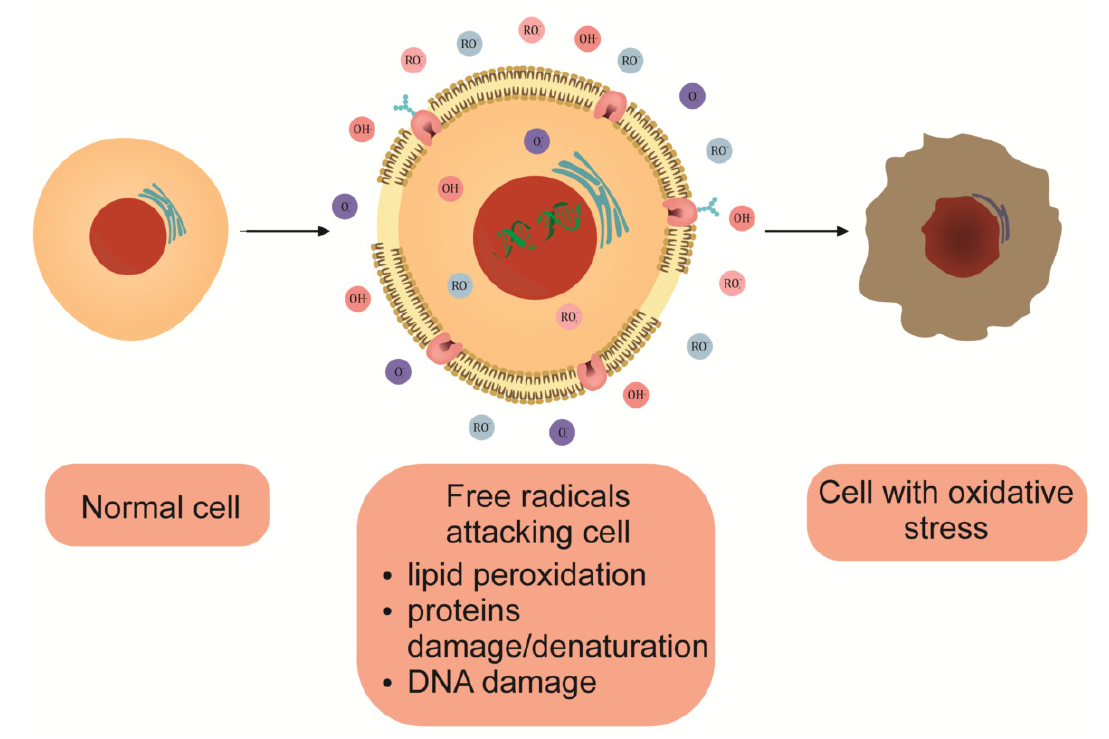
Figure 2. The effect of oxidative stress on the eukaryotic cell.